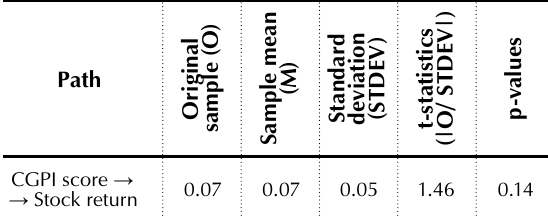
Table 4. P-values of indirect influence